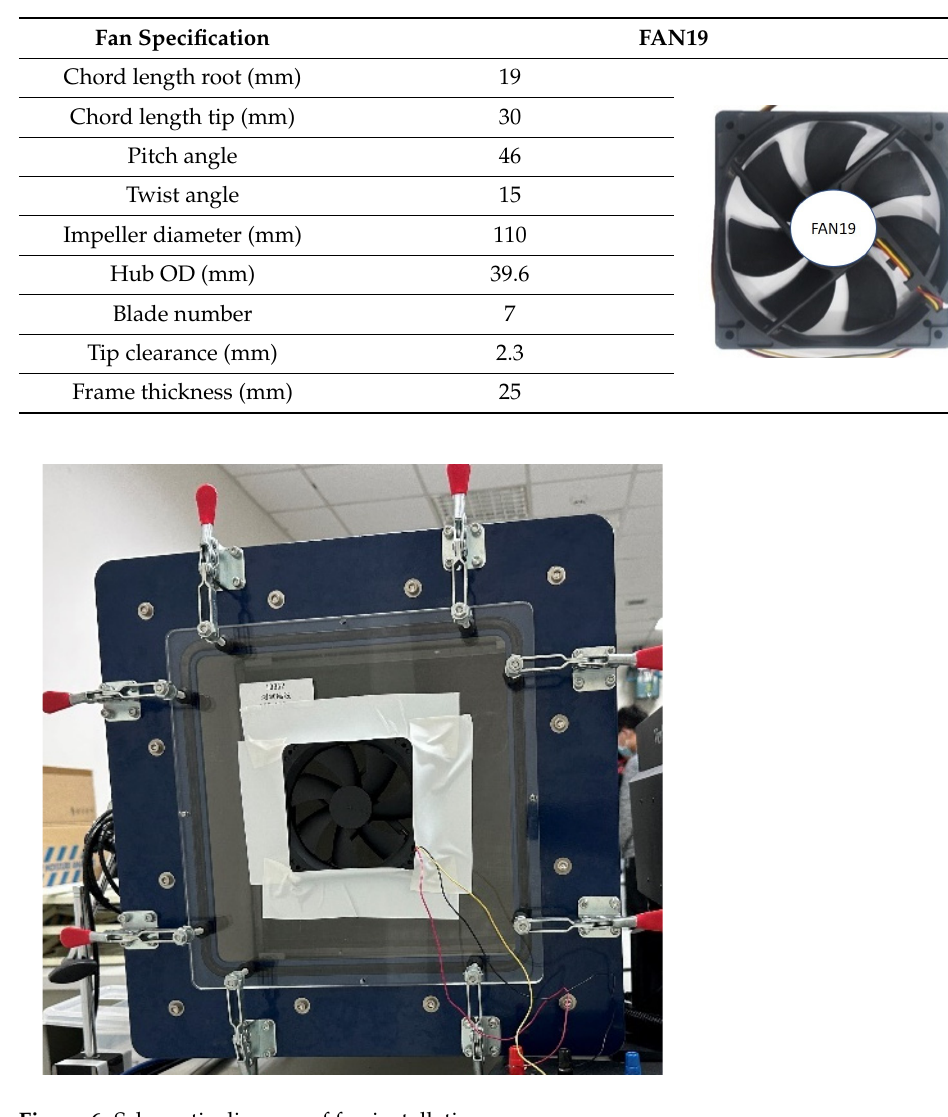
Figure 6. Schematic diagram of fan installation.